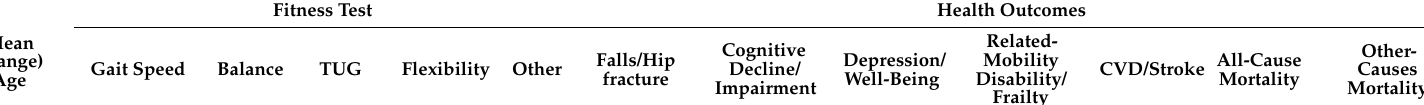
Table 3. Main characteristics and findings of longitudinal studies investigating the predictive validity of motor fitness and flexibility tests for health outcomes in adults and older adults.